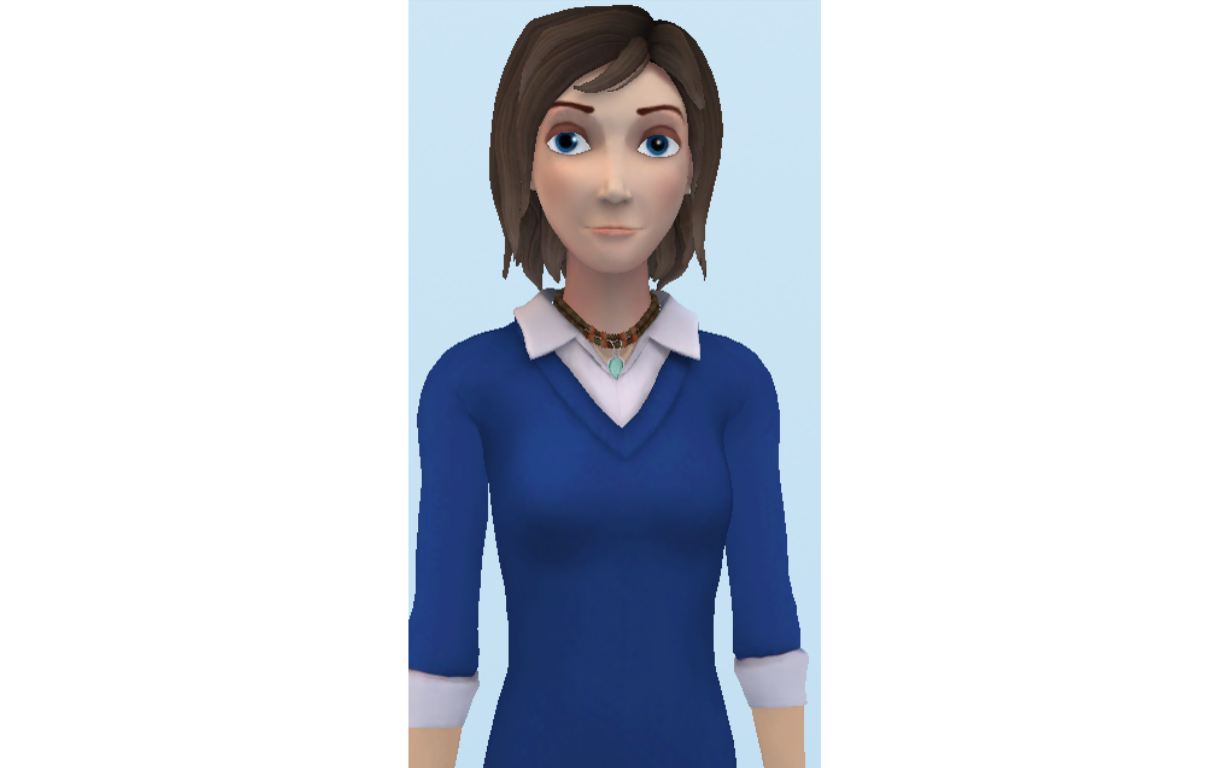
Figure 1. Laura, the embodied conversational